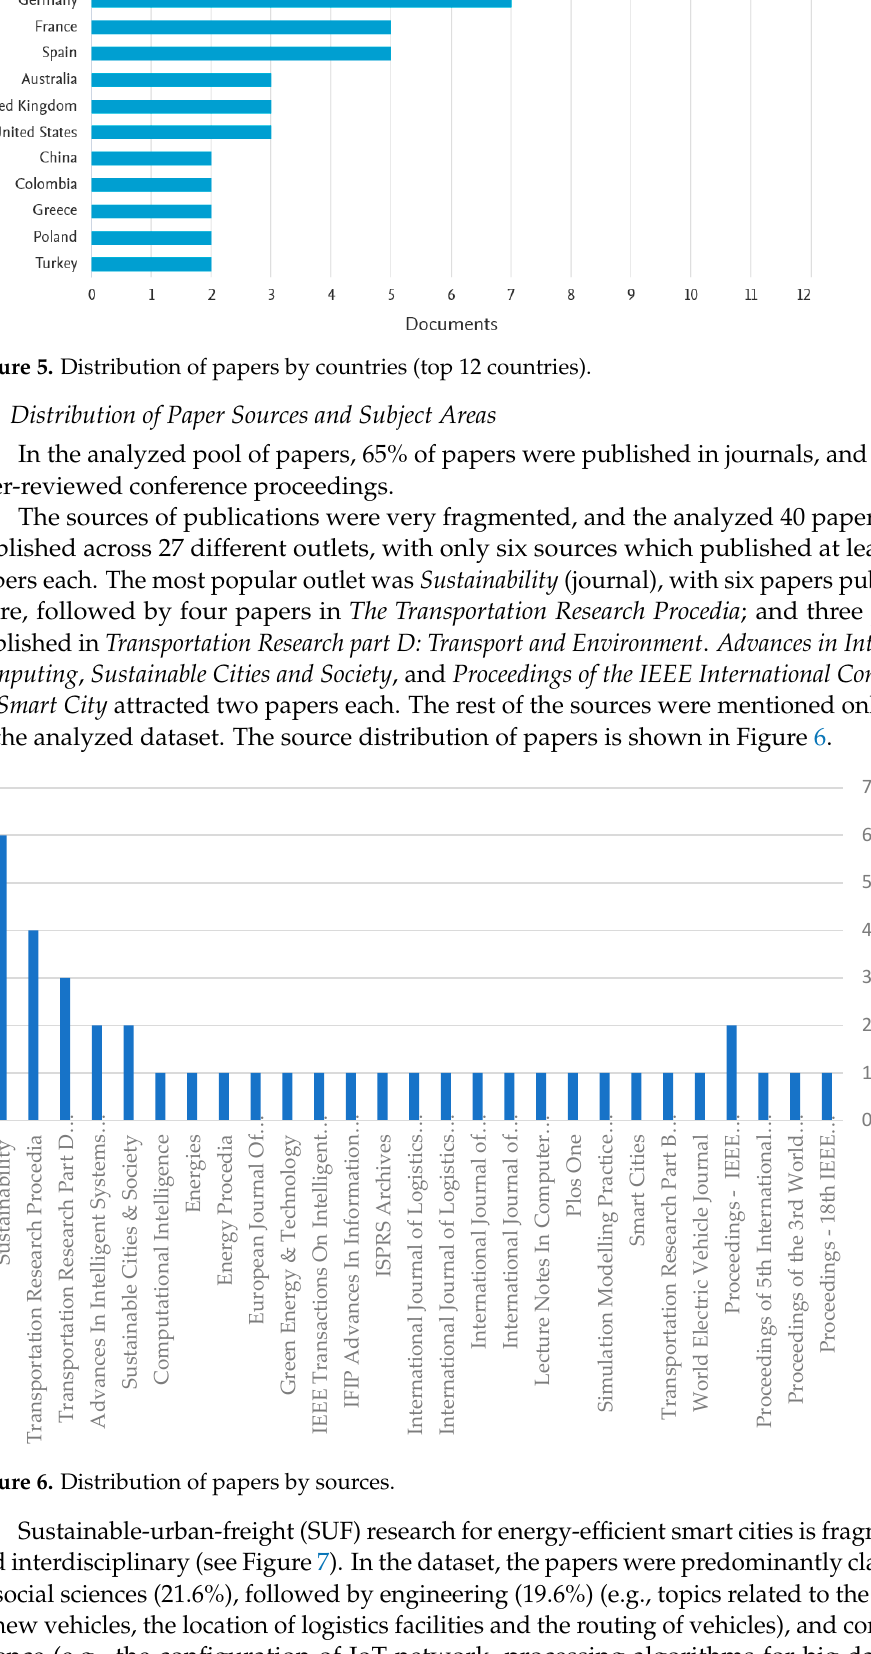
Figure 6. Distribution of papers by sources.